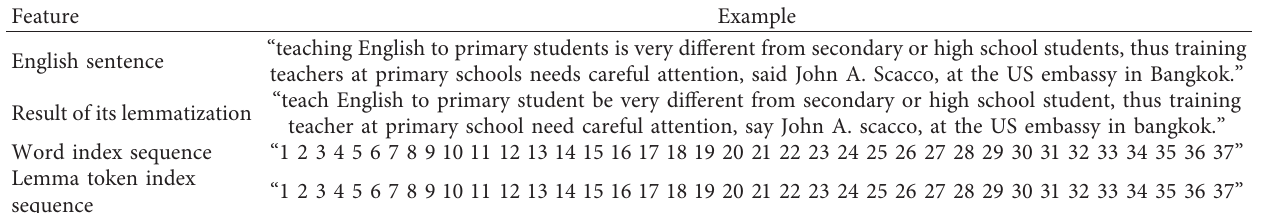
Table 4: An English sentence and the result of its lemmatization Feature Example English